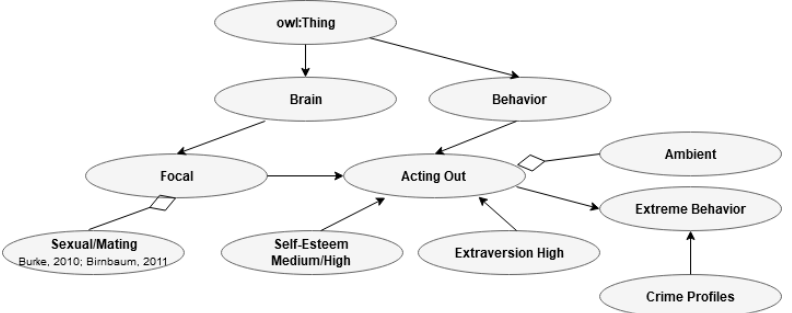
Figure 13. The relationships between acting out in one of the B’s, individual traits (I), and extreme behavior in